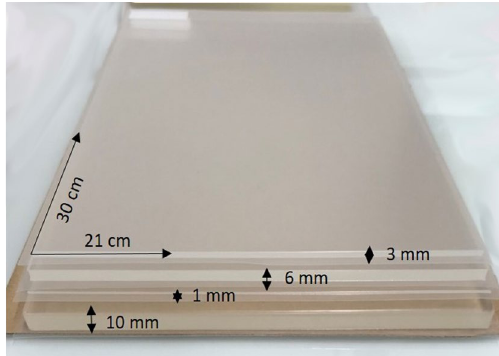
Figure 1. Multi-layered phantom tissue model.